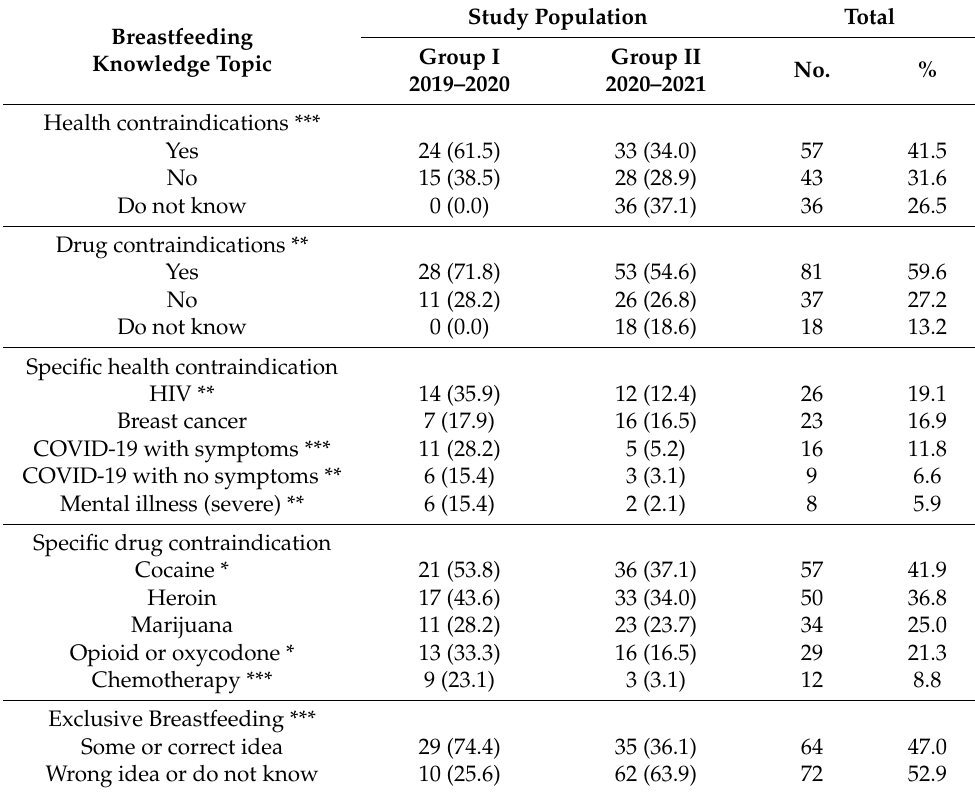
Table 4. Breastfeeding contraindication awareness among participating